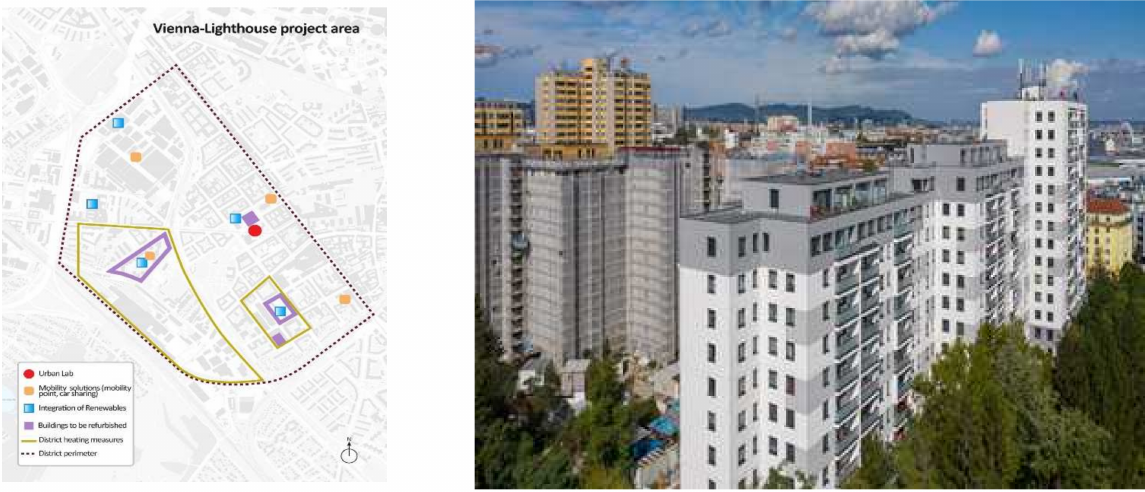
Figure 5. Simmering district in Vienna ( left ) and Hauffgasse 37–47 after refurbishment ( right )